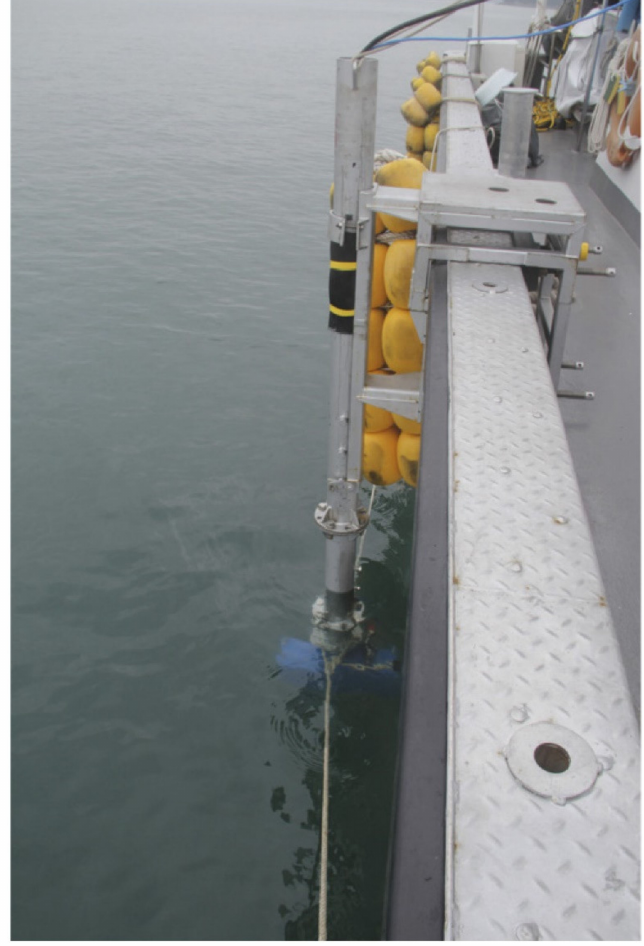
Figure 1. Photograph of a multibeam echo sounder